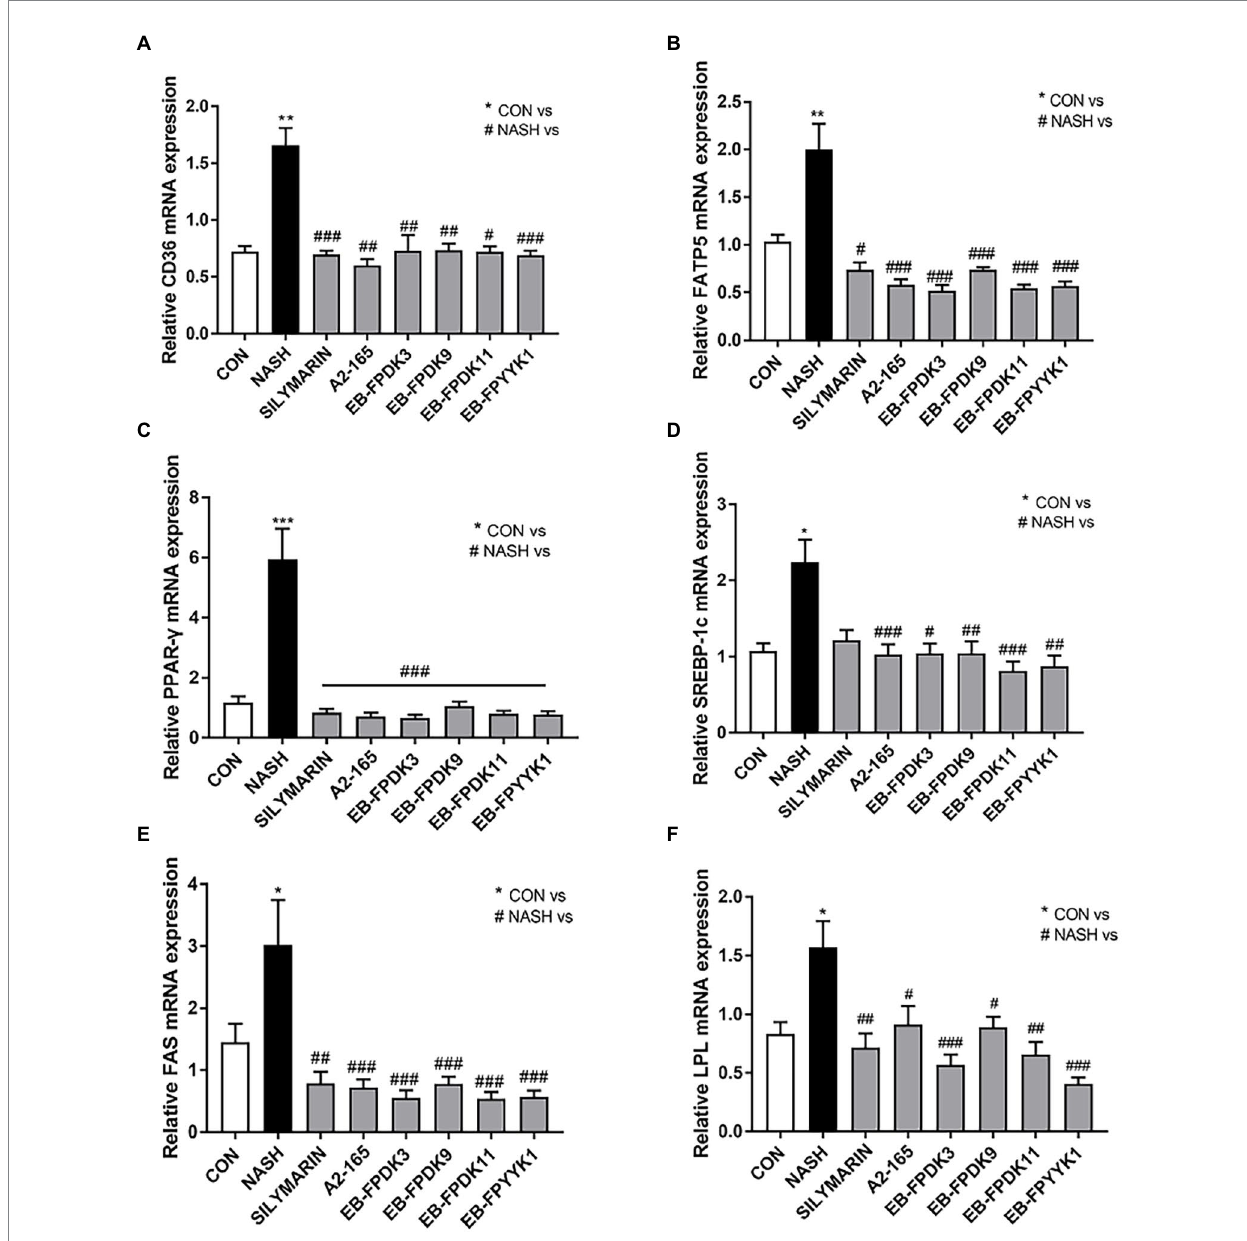
FIGURE 7 Faecalibacterium prausnitzii reduces hepatic steatosis and alleviates liver fat disease. mRNA levels of hepatic steatosis markers (A) CD36, (B) FATP5, (C) PPAR- 𝛾 , (D) SREBP-1c, (E) FAS, and (F) LPL. Statistical analyzes were performed using Kruskal–Wallis one-way ANOVA with Dunn’s test (A,D,E) or Mann–Whitney U test (two tailed) (B,C,F) . ∗ p < 0.05, ∗∗ p < 0.01, ∗∗∗ p < 0.001 versus the CON group; # p < 0.05, ## p < 0.01, ### p < 0.001 versus the NASH group. FATP5, fatty acid transport protein-5; PPAR- 𝛾 , peroxisome proliferator-activated receptor gamma; SREBP-1c, sterol regulatory element-binding protein-1c; FAS, fatty acid synthase; LPL, lipoprotein lipase; CON, control; NASH, nonalcoholic